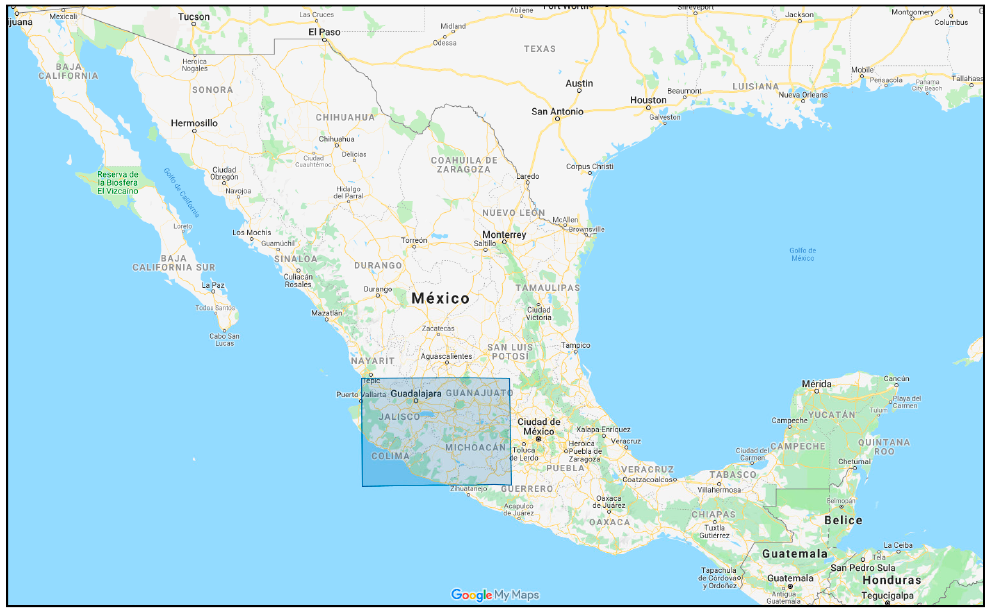
Figure 1. Geographical region for the problem.